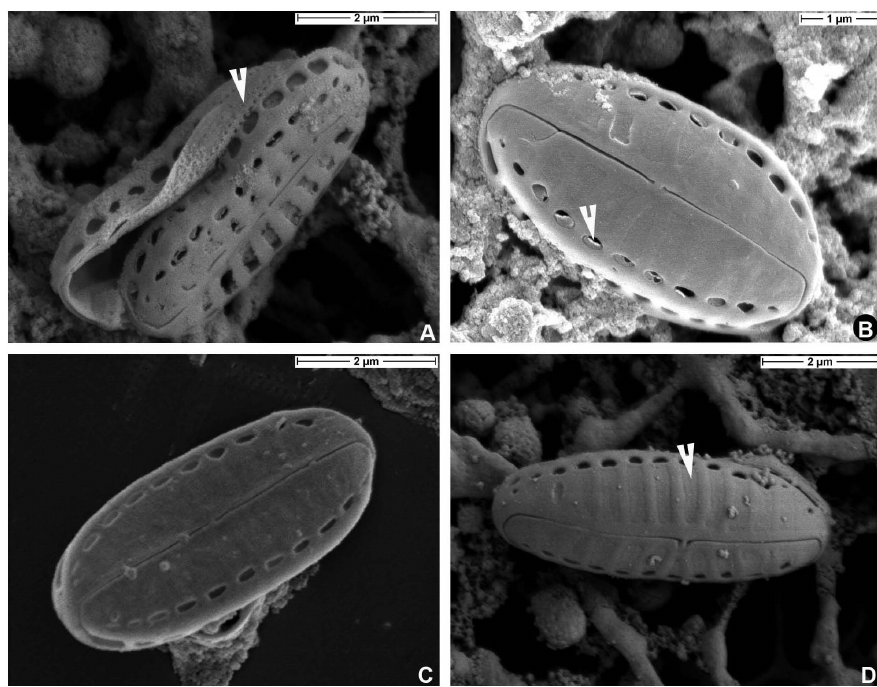
Figure 4. Biremis panamae sp. nov., SEM: external valve views. A. Frustule with detached valves and a part of a copula with several rows of pores (arrowhead). B. Valve face showing occlusions of the marginal row of small areolae (arrowhead). C, D. External valve view showing variation in the valve face morphology. Note the depressed surface of the valve face areola occlusions